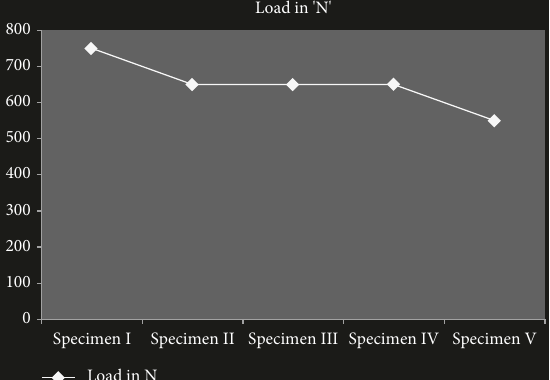
Figure 12: Tensile strength of each specimen.